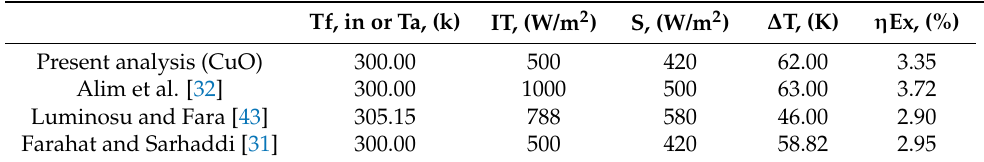
Table 6. Comparison among the present analysis, experimental results, and computer simulation. Tf, in or Ta, (k) IT, (W/m 2 ) S, (W/m 2